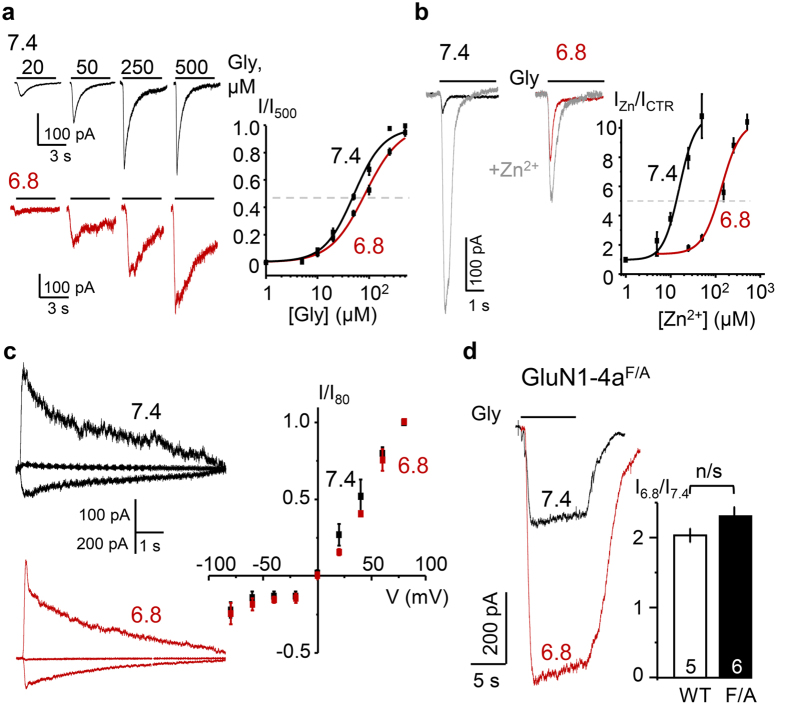
Protons alter sensitivities to LBD ligands and act through a novel site.(a) Glycine-dose dependency of Ipk, at two pH values. (b) Glycine-elicited currents recorded in the continuous presence (50 μM, grey) or absence (0 μM, black or red) of external Zn2+ at two pH values, and zinc-dose dependency of Ipk change relative to 0 Zn2+ (ICTR), at two pH values. (c) Glycine-elicited currents recorded with 1.8 mM external Ca2+ at several holding potentials, and the voltage dependence of Ipk relative to +80 mV (I80) at two pH values. (d) Glycine-elicited currents from cells expressing GluN1-4aF484A and GluN3A (GluN1-4aF/A) at two pH values and summary of changes in Ipk. Values are means ± SEM; sample size is in bars; n/s, P > 0.05.